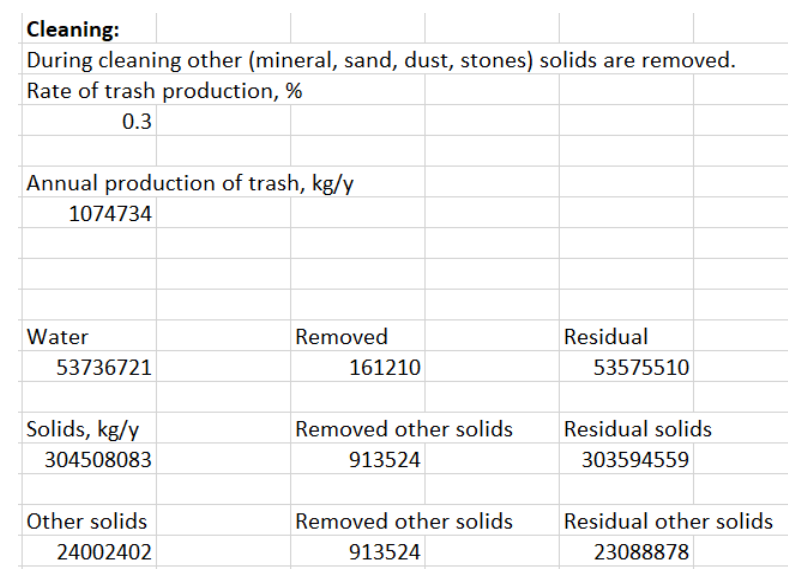
Figure 1. The cleaning process from the ‘Flowchart’ page in the Supplementary Materials (Excel spreadsheet, Technoeconomic Model).